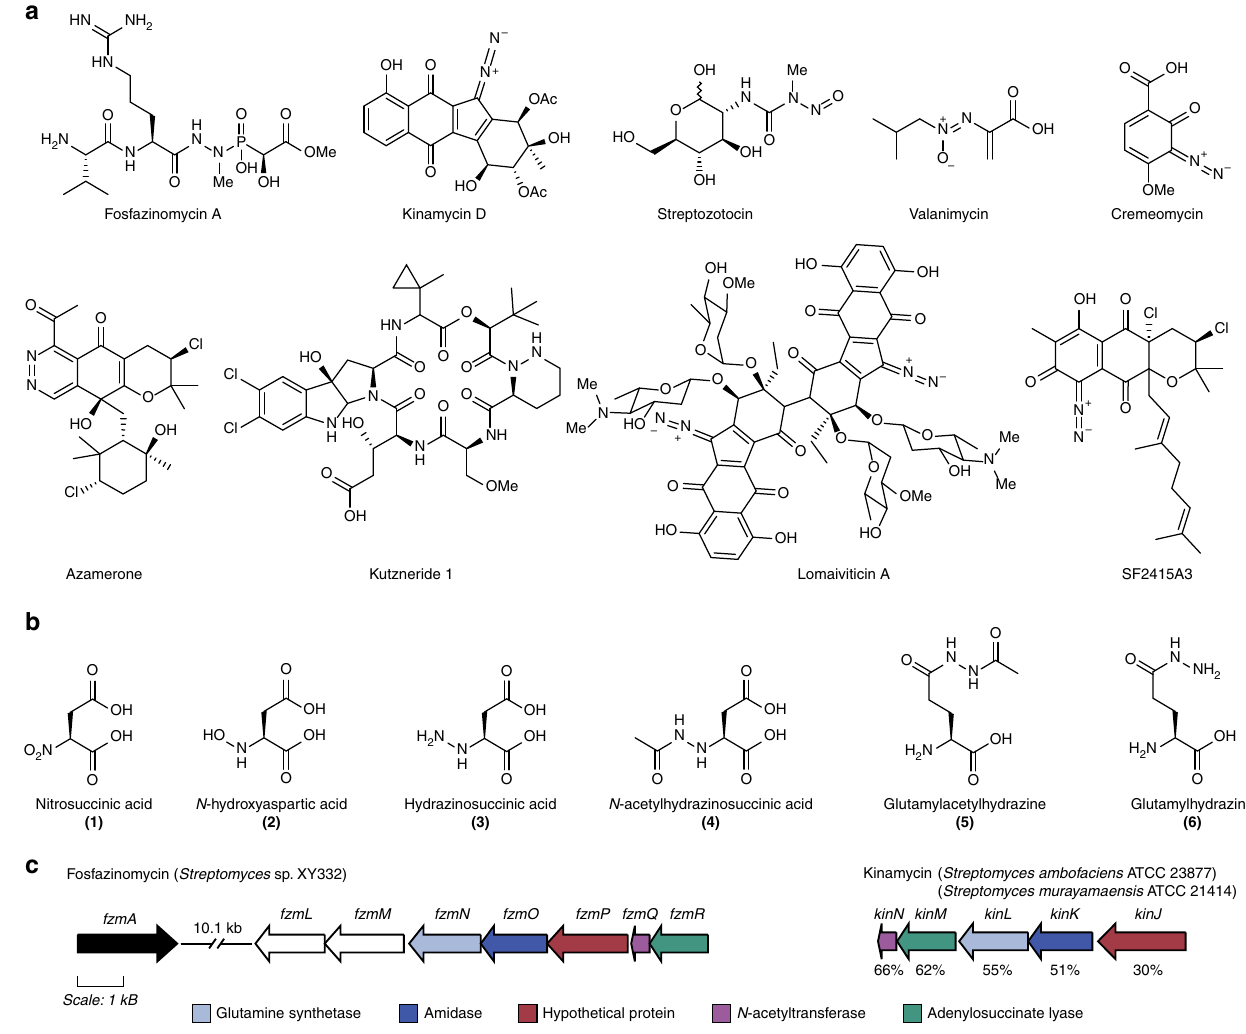
Fig. 1 Structures and biosynthetic gene clusters of fosfazinomycin and kinamycin. a Structures of a select group of N – N bond-containing natural products. b Structures of the biosynthetic intermediates discussed in this study. c Selected segments of the biosynthetic gene clusters of fosfazinomycin and kinamycin that encompass the genes discussed in this study. The fi ve conserved genes in the two clusters are colored based on annotations of their gene products using BLAST analysis: glutamine synthetase (blue-gray), amidase (dark blue), hypothetical protein (red), N -acetyltransferase (purple), and adenylosuccinate lyase (green). The amino acid identities between the homologous enzymes from the fzm cluster from Streptomyces sp. XY332 and the kin cluster from Streptomyces murayamaensis ATCC 21414 (FzmN/KinL, FzmO/KinK, FzmP/KinJ, FzmQ/KinN, and FzmR/KinM) are indicated below the kin cluster. fzmL and fzmM , which encode enzymes responsible for forming nitrous acid from aspartic acid, are colored in